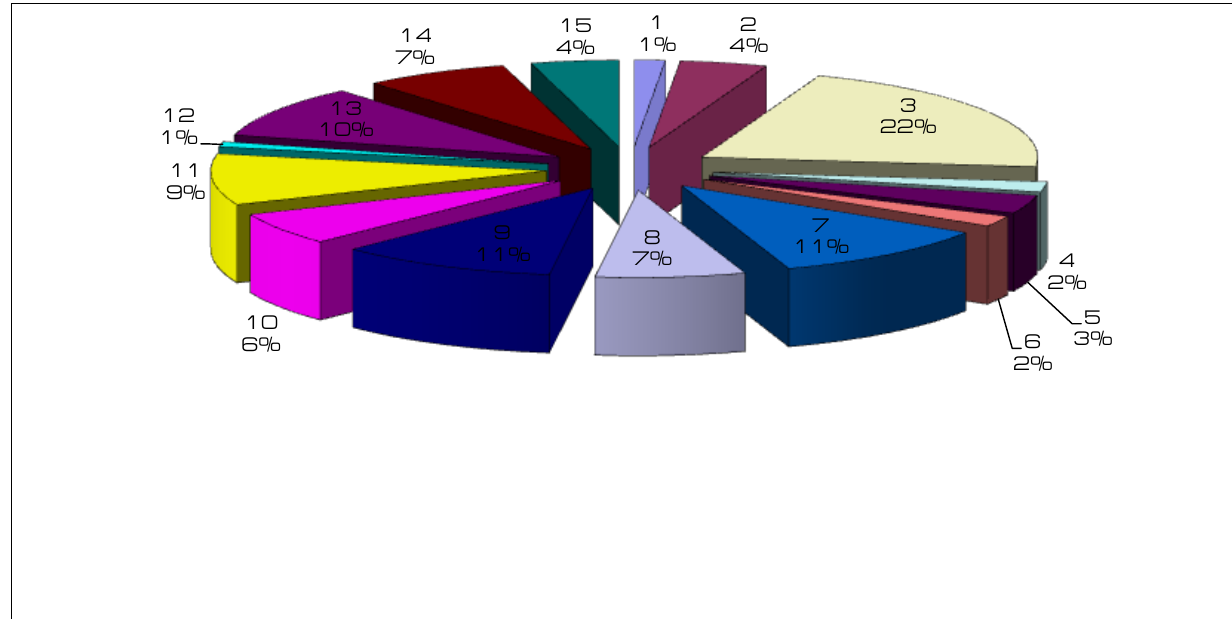
Fig.2. Diagram of significance of anatomic-morphological indicators for central